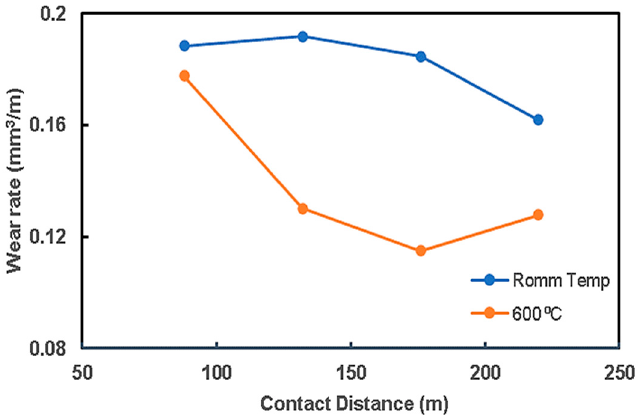
Figure 10. The wear rate of Cu/Fe composite (QMMC) against the contact speed with the abrasive disc.